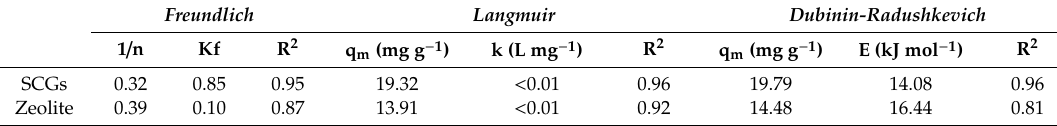
Table 2. Adsorption parameters of spent co ff ee grounds (SCGs) and zeolite for cadmium, fitted with the Freundlich , Langmuir , and Dubinin-Radushkevich equation. Freundlich Langmuir